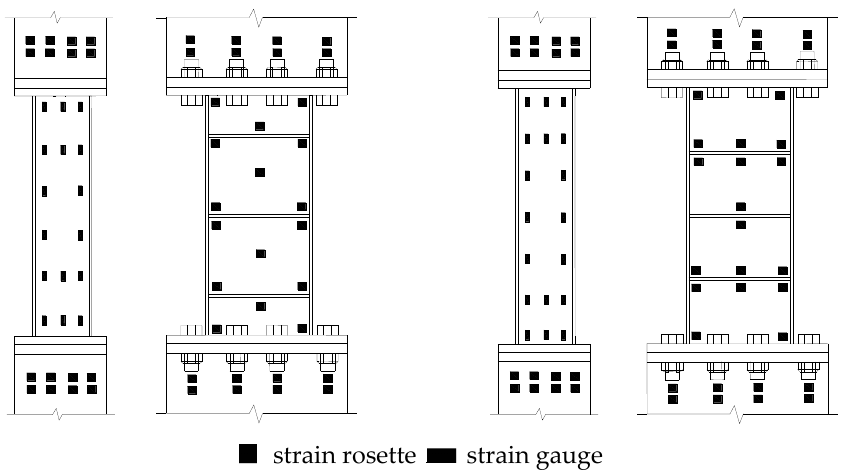
Figure 4. The measurement arrangement of strain gauge and strain rosette.